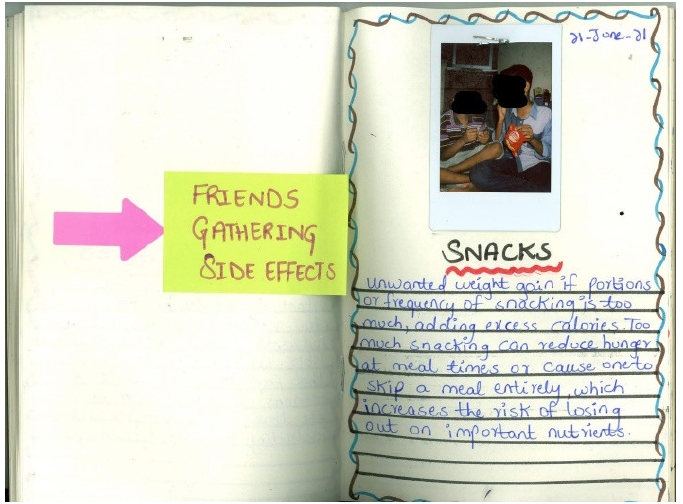
Figure 5. David’s photodiary: Friends gathering side effects. Snacks. Unwanted weight gain if portions or frequency of snacking is too much, adding excess calories. Too much snacking can reduce hunger at mealtimes or cause one to skip a meal entirely, which increases the risk of losing out on important nutrients [written in English].